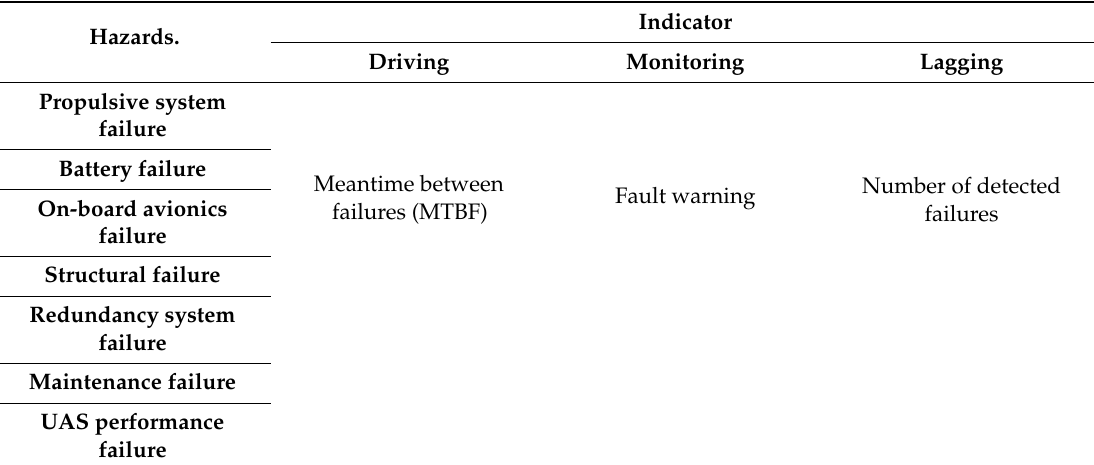
Table 3. Safety indicators regarding vehicle reliability, equipage and redundancy. Hazards.